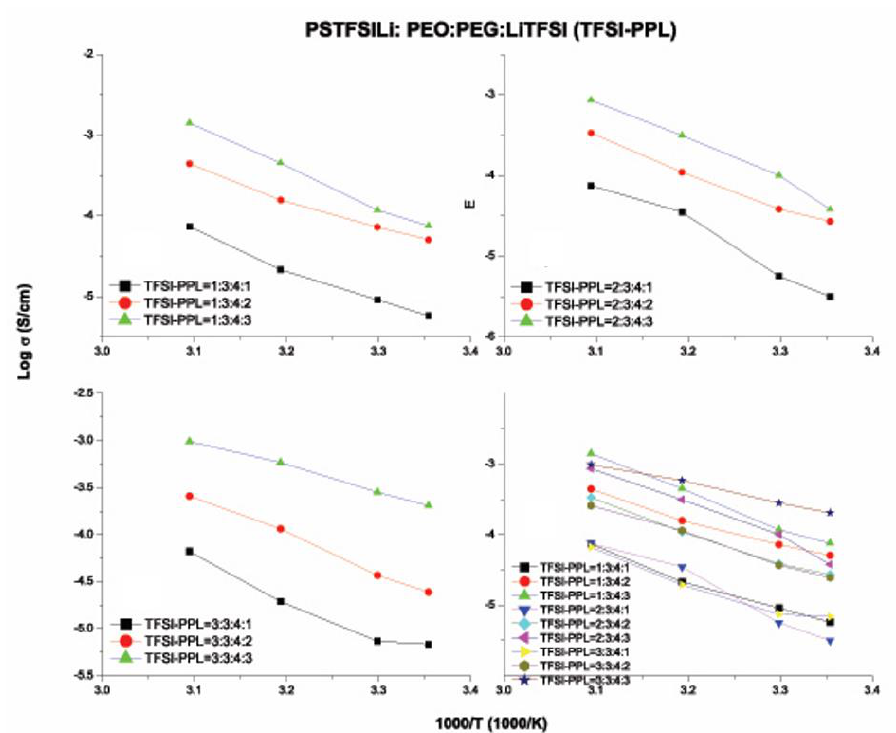
Figure 11. Ionic conductivity versus temperature of various weight ratios of PSTFSILi–PEO–PEGDM– LiTFSI (TFSI–PPL) electrolytes.